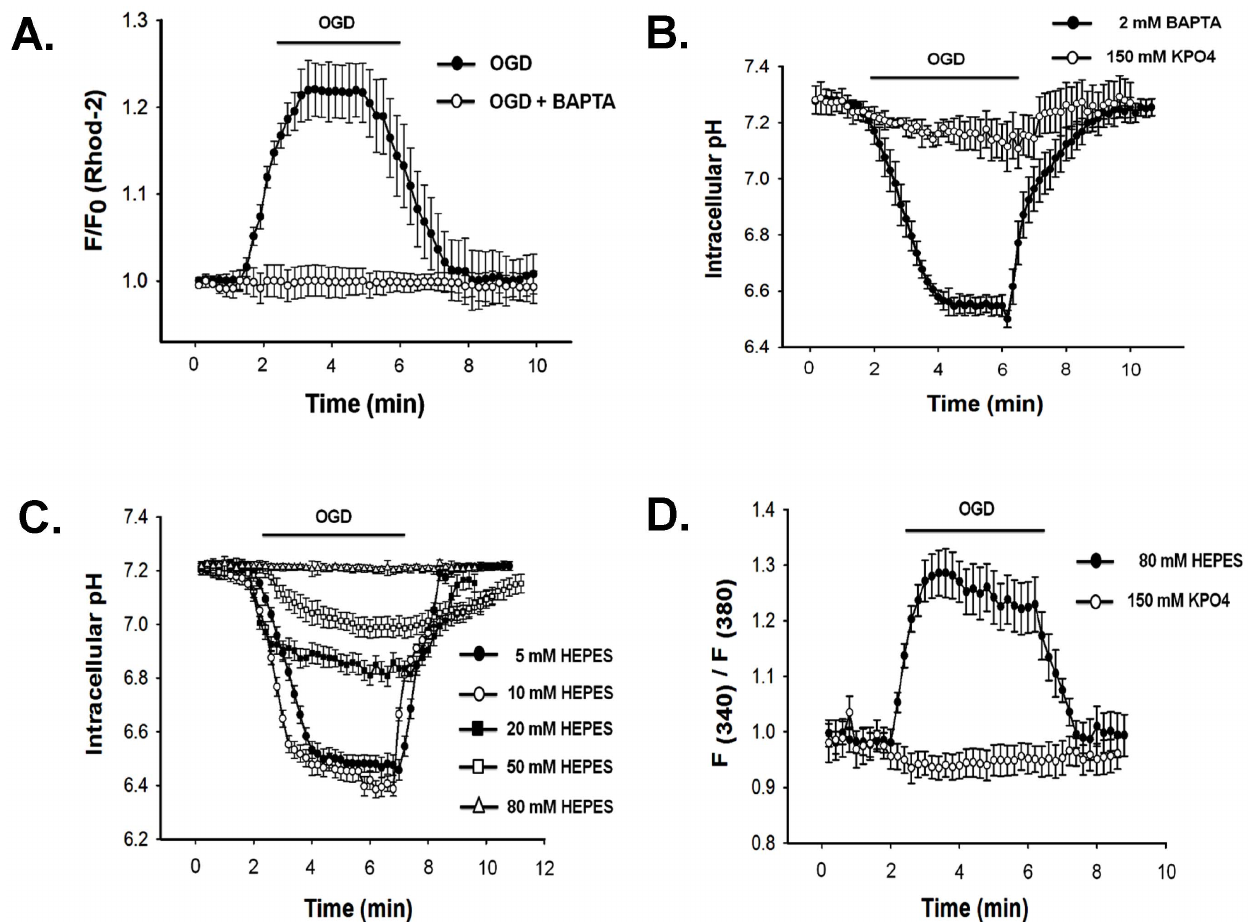
Figure 5. Clamping of intracellular calcium ([Ca 2 + ] i ) and (pH i ) during OGD. A . Addition of 2 mM BAPTA in the pipette solution restricted [Ca 2 + ] i rise during OGD. Rhod-2 dye was used to determine [Ca 2 + ] i in presence of BAPTA. B . 2 mM BAPTA did not affect OGD induced acidosis, whereas 150 mM